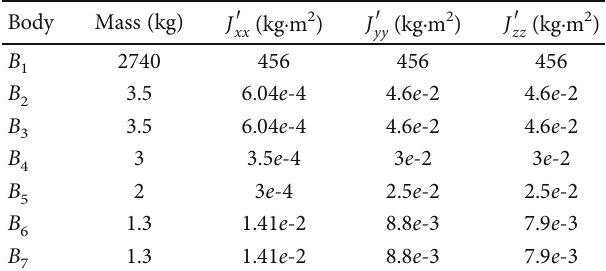
Table 1: Inertia parameters of the space robot.